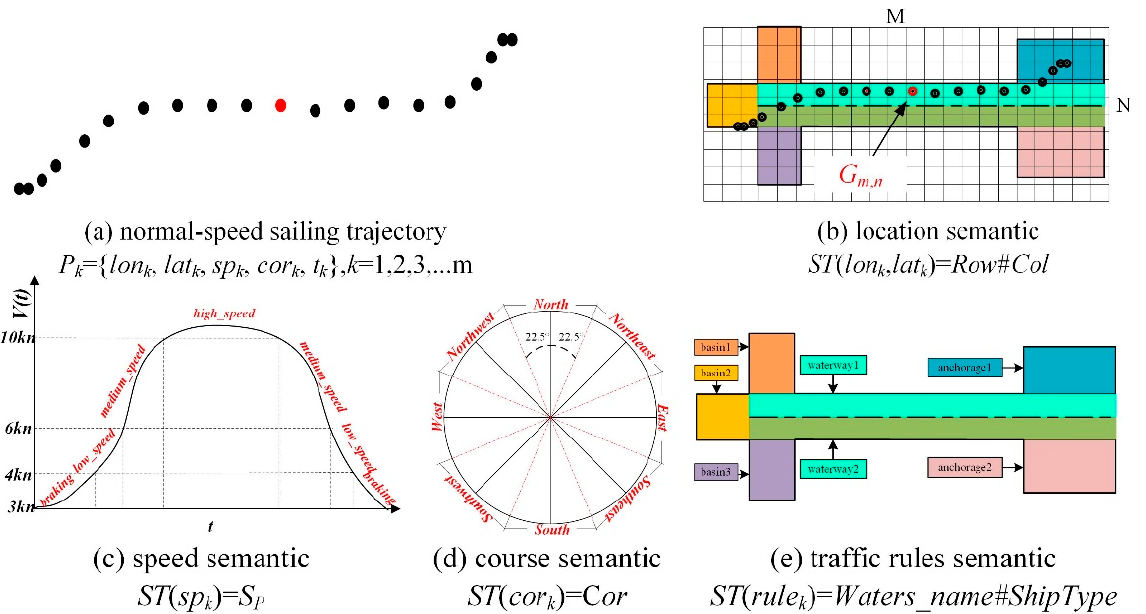
Figure 3. Semantic transformation and enrichment of ship motion features.